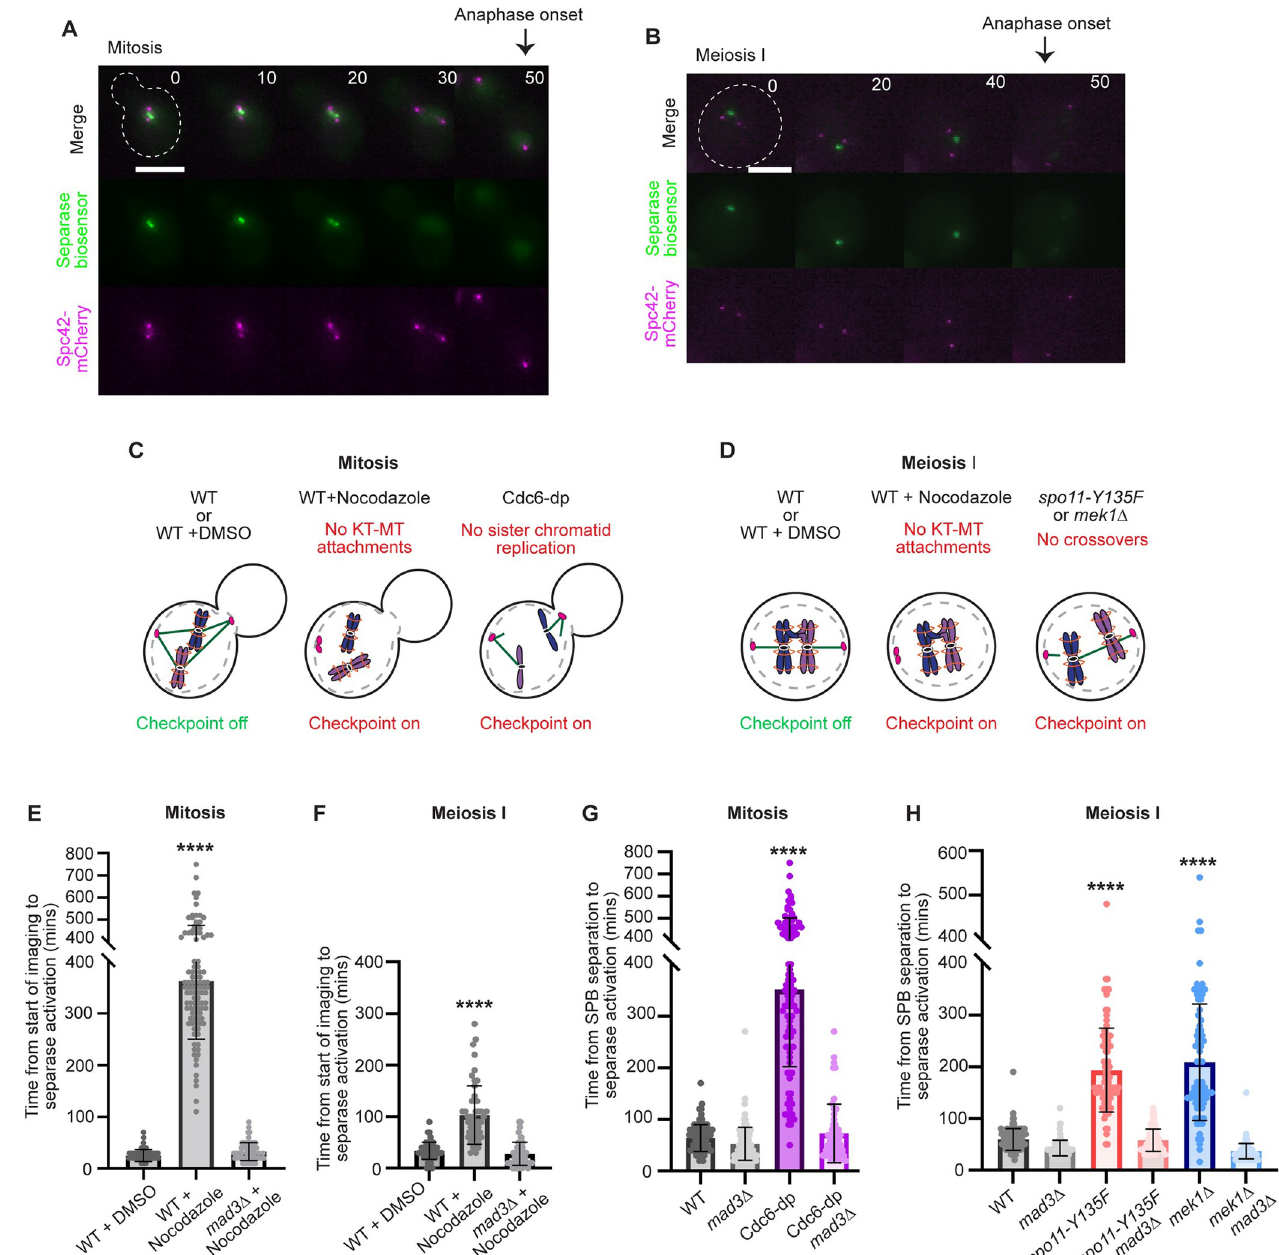
Fig 1. The spindle checkpoint is less persistent in meiosis compared to mitosis. (A-B) Representative time lapse images of a cell harboring Spc42-mCherry and the separase biosensor in mitosis (A) and meiosis I (B). Time from SPB separation to separase activation. Time 0 indicates SPB separation. Scale bar = 5 μ m. (C-D) Cartoons depicting activation of the spindle checkpoint through loss of kinetochore (KT) tension and loss of kinetochore-microtubule (KT-MT) attachments in mitosis (C) and meiosis I (D) Wildtype = WT. E) Graph depicting mean time from start of movie to anaphase onset in mitosis following treatment with DMSO or nocodazole. Asterisk indicates statistically significant difference between DMSO-treated and nocodazole-treated cells (p < 0.0001, Mann-Whitney test) and error bars show standard deviation (SD) n � 50 cells per genotype. F) Graph depicting mean time from start of movie to anaphase onset in meiosis following treatment with DMSO or nocodazole. (G-H) Graph showing the mean time from SPB separation to anaphase onset in mitosis (G) and meiosis I (H). Asterisks indicate statistically significant difference between wildtype and mutants (p < 0.0001, Mann-Whitney test). Error bars show SD. n � 100 cells per